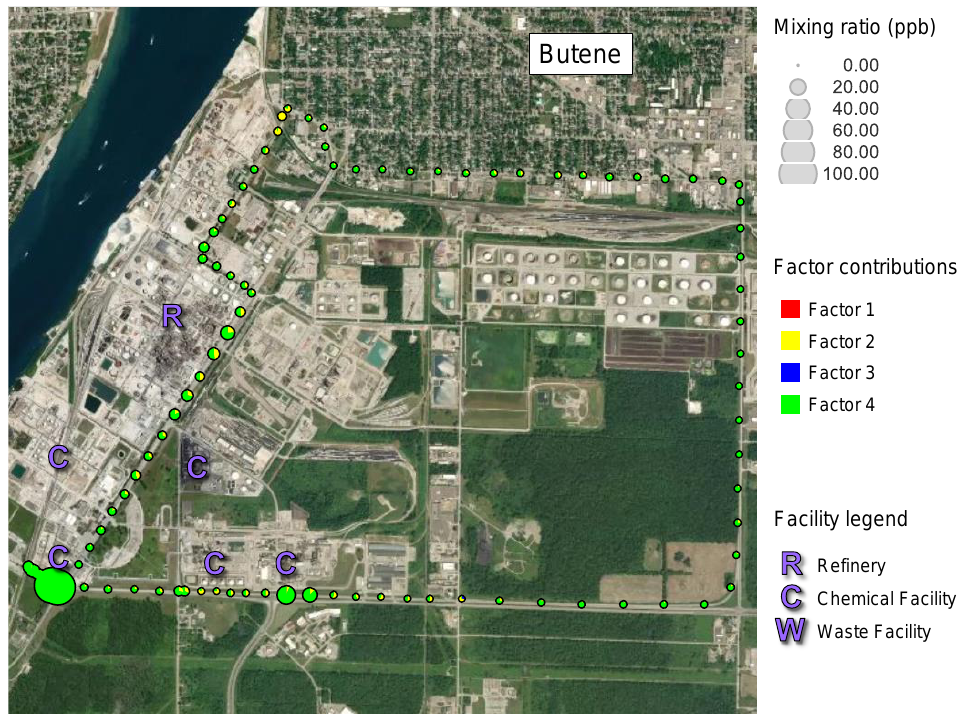
Figure 9. Contributions of each of the four local factors to butene mixing ratios as a function of measurement location while mobile on 17 June 2020, 13:10 – 13:35. Wind was northerly at the time. The diameter of each pie denotes the butene mixing ratio and the size of each wedge within each pie represents the relative contribution of each factor for that measurement period. It is important to note that reported butene mixing ratios should be considered as an upper limit due to interferences at m / z 57 from the fragmentation of alkanes.